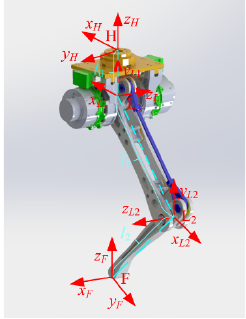
Figure 2. Structure of single leg.